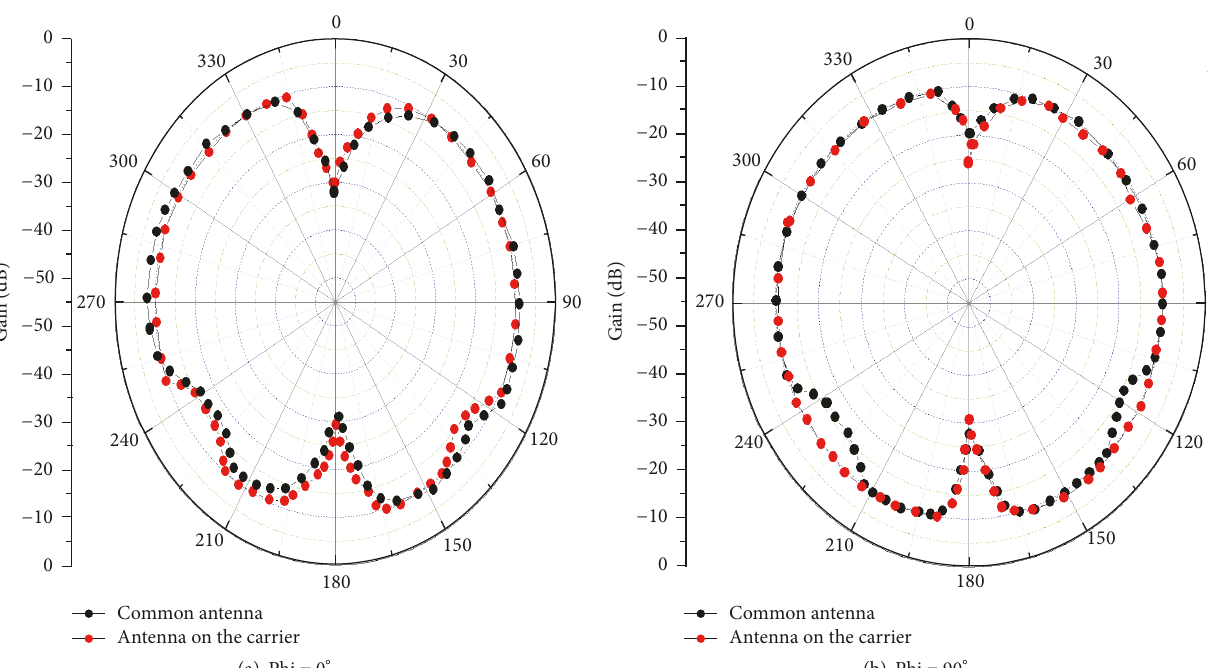
Figure 18: Influence of glass reinforced plastic material vertical polarization antenna.